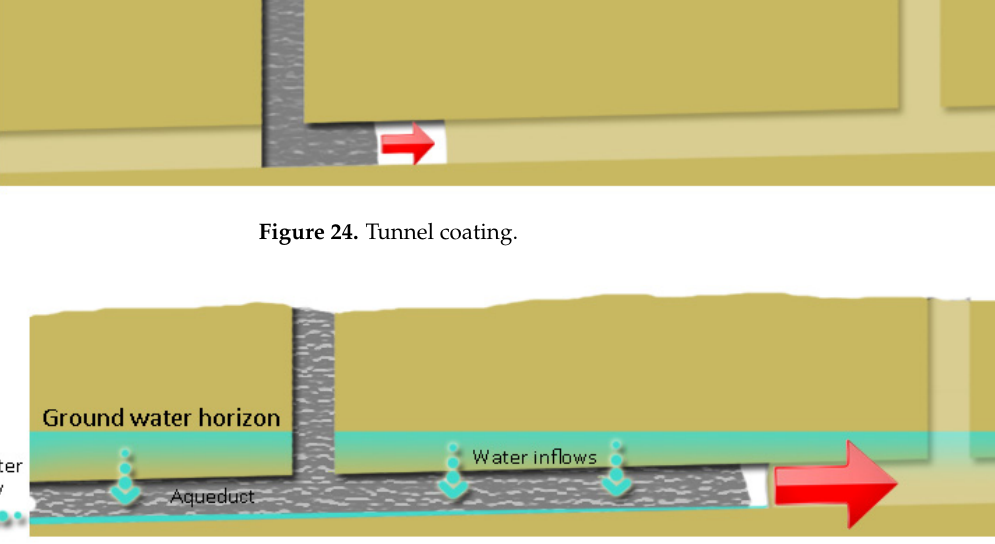
Figure 25. Linear construction, where the aqueduct is under the groundwater horizon.